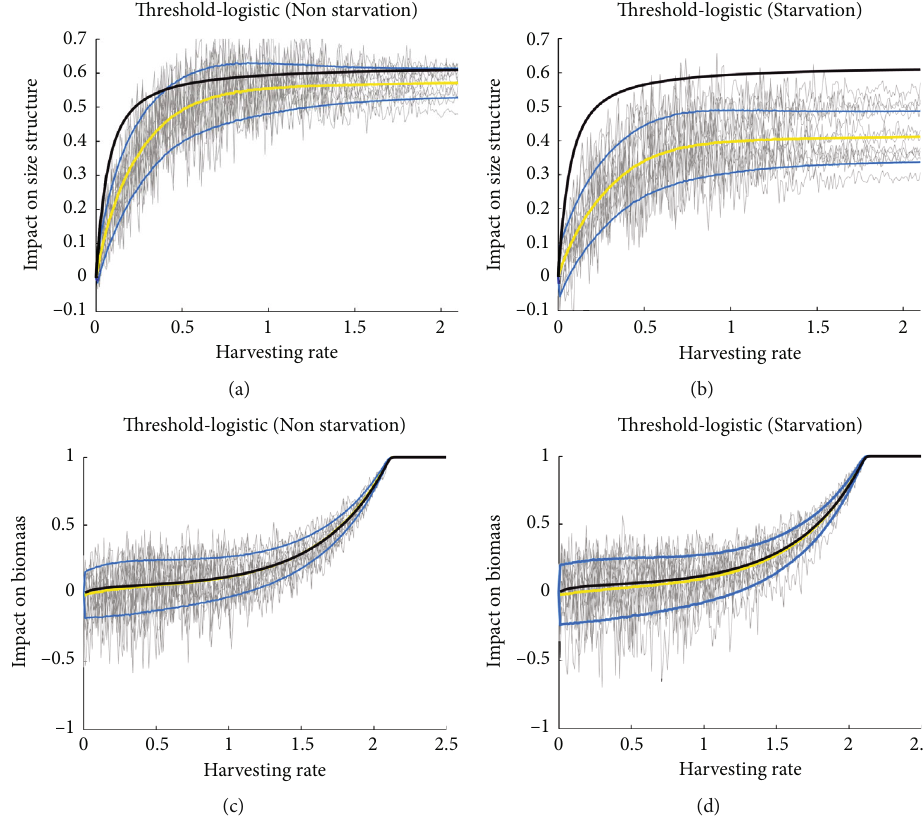
Figure 9: Impact on size structure and biomass of threshold-logistic growth rate without starvation (a, c) and with starvation (b, d) at steady state w.r.t. harvesting rate. The grey trajectories show the impact on size structure and biomass from di ff erent simulations for the stochastic case. The yellow curve represents the mean value of the simulations. The light blue curves represent the interval of standard deviation (68%). The black curve represents the impact on size structure and biomass for the deterministic case. Equations (17) and (18) are used to derive the above graphs for the impact on size structure and biomass,